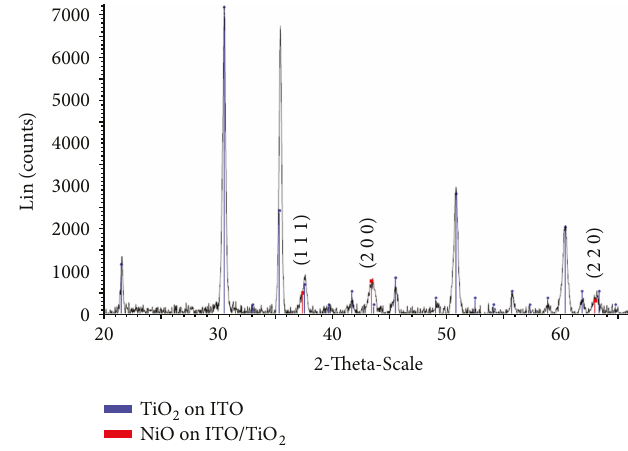
Figure 7: XRD of fabricated ITO/TiO solar